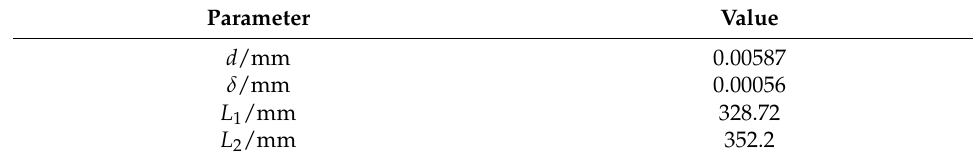
Figure 5. The physical model of Taylor’s experiment [18]. Table 2. The physical model parameters of Taylor’s experiment [18].